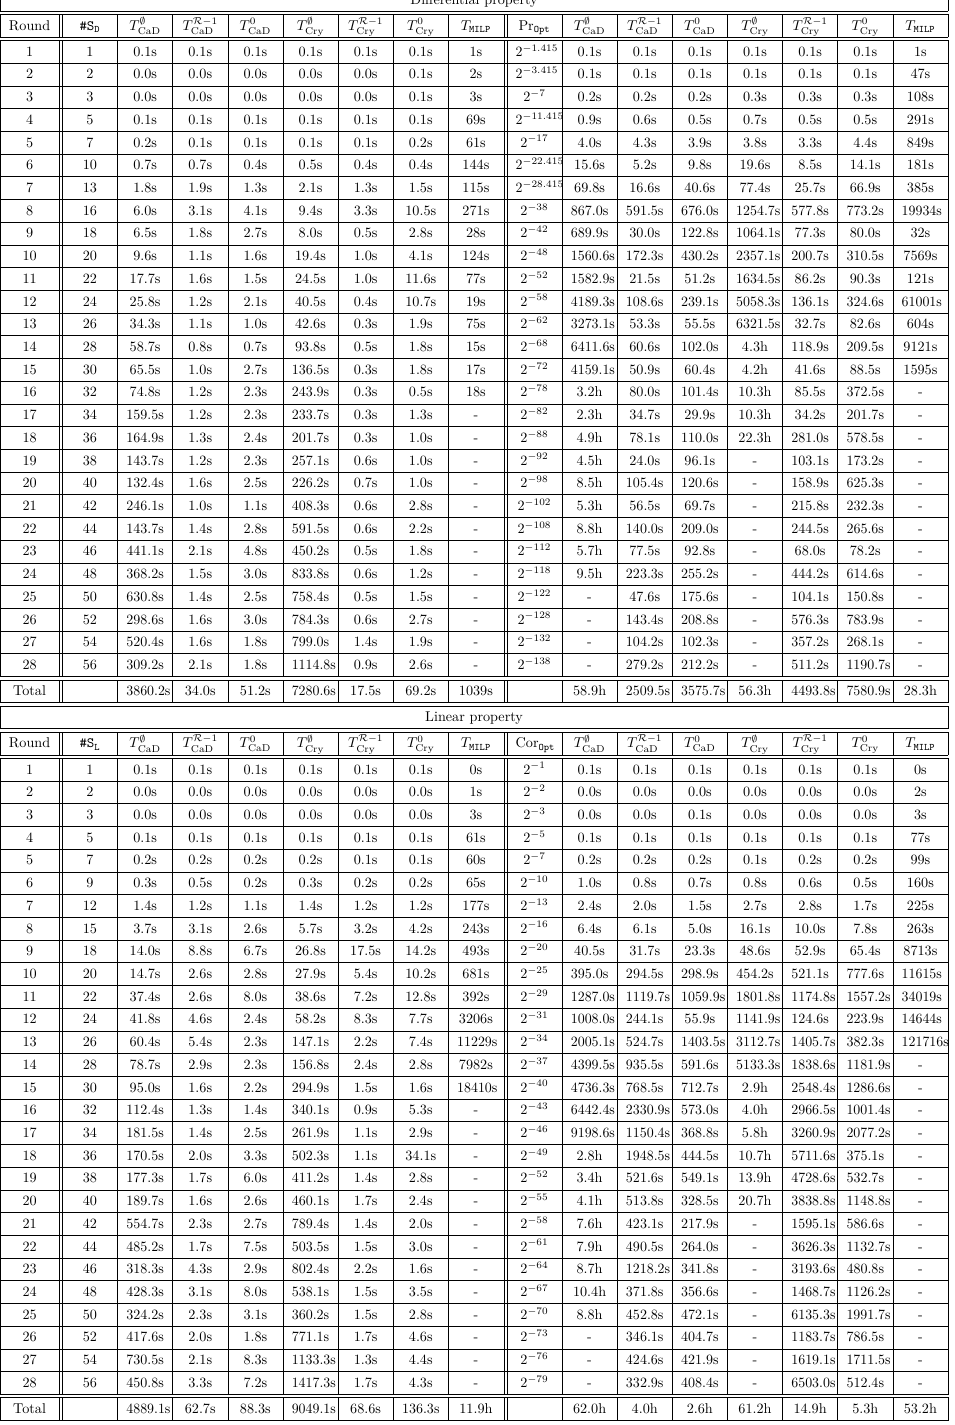
Table 13: Experimental results of GIFT-64